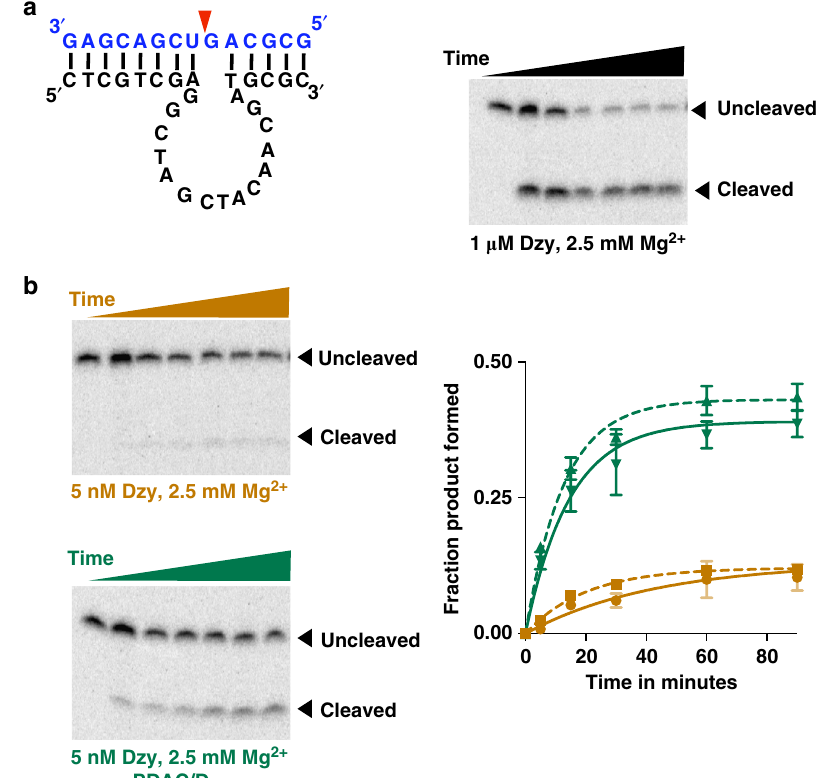
Fig. 7 Coacervate-mediated stimulation of a DNAzyme. a Structure of the 10 – 23 DNAzyme. The enzyme strand is shown in black and the substrate is shown in blue. The red arrow indicates the cleavage site. Gel image shows ef fi cient cleavage of the substrate (0.25 pM) by the enzyme (1 µ M) in 25mM Tris – HCl pH 8.0 containing 2.5mM MgCl 2 and 2.5mM KCl. Time points were taken at 0, 2.5, 5, 15, 30, 60, and 90min. b Reactions contained 5nM of the enzyme strand and 0.25 pM substrate strand in 25mM Tris – HCl pH 8.0 containing 2.5mM MgCl 2 and 2.5mM KCl. Coacervates were formed by adding PDAC-53 and D 10 at 10mM total charge from each. Time points were taken at 0, 5, 15, 30, 60, 90, and 120min. Fraction product formed were calculated from gels shown in b and Supplementary Figure 13 and data were fi t to Eq. (1). Green solid and dashed lines indicate experiments performed in 2.5mM Mg 2 + or 5mM Mg 2 + , respectively. All error bars represent S.E.M. ( n = 3) from three independent experiments. Uncropped gel images are shown in Supplementary Figure